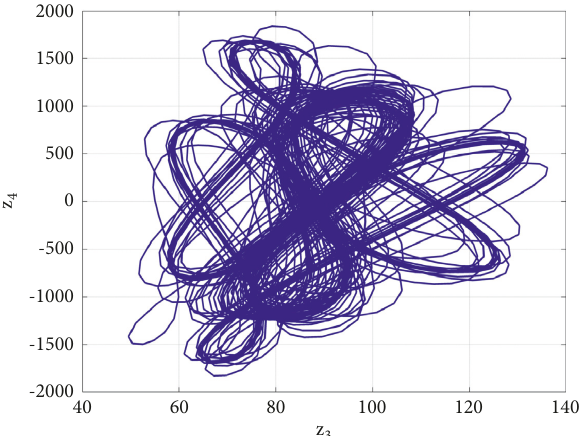
Figure 24: A chaotic attractor of the model (1) for d � 1045 and ( a,b, c ) � ( 25 , 8 , 90 ) .